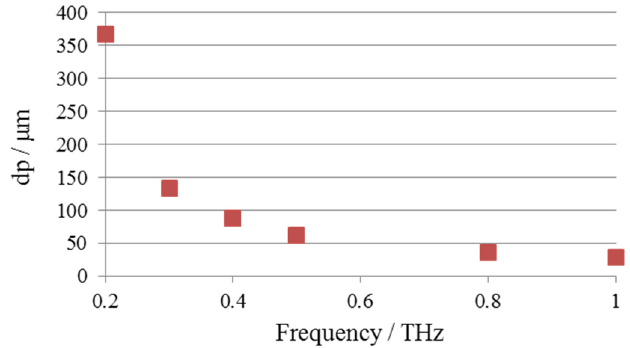
Figure 2. Frequency dependence of the penetration depth d p .